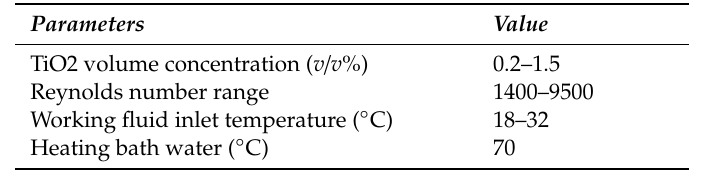
Table 1. Experimental conditions in the present study.